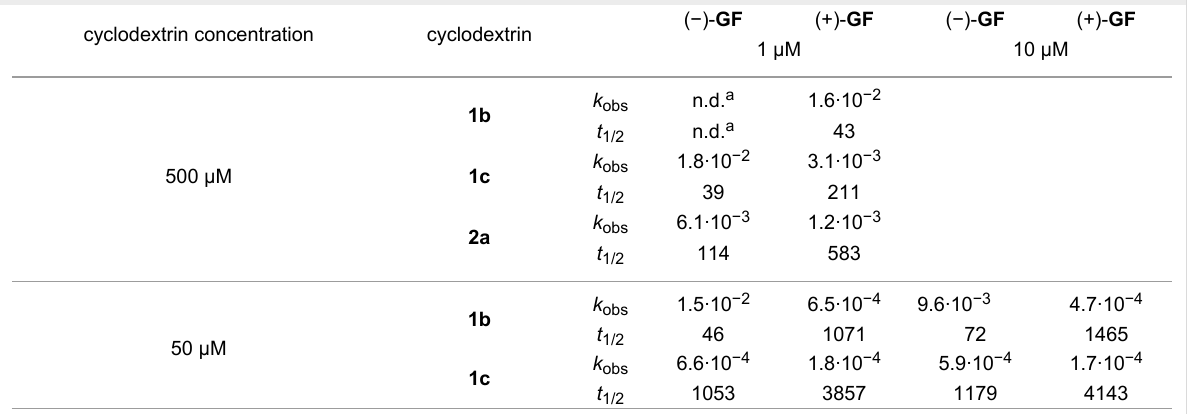
Table 1: Kinetic constants determined for GF degradation mediated by cyclodextrins 1b , 1c , and 2a ( k obs in s − 1 , t 1/2 in s). cyclodextrin